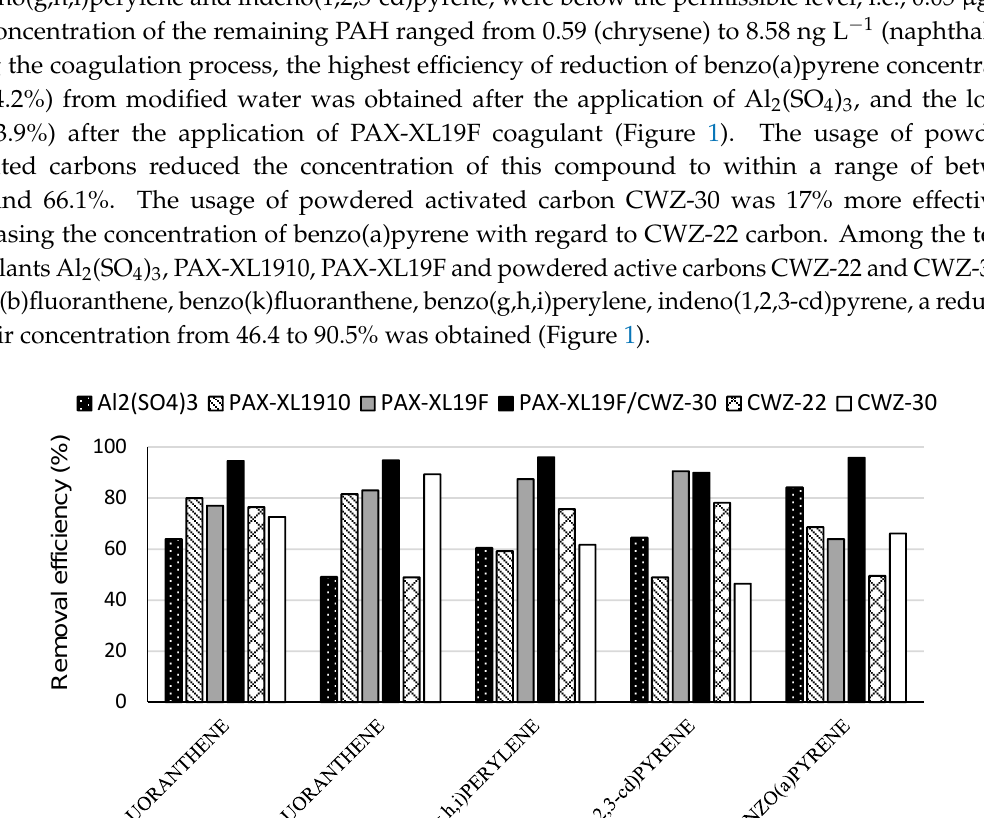
Figure 2. Removal efficiency of sum PAH standardized in the Council Directive 98/83/EC on the quality of water intended for human consumption. Among the tested coagulants Al 2 (SO 4 ) 3 , PAX ‐ XL1910, PAX ‐ XL19F and powdered active carbons CWZ ‐ 22 and CWZ ‐ 30, the lowest PAH removal from water efficiency was obtained for 2 ‐ and 3 ‐ ring compounds (Figure 3). In case of 2 ‐ ring naphthalene, the removal efficiency ranged from 34.9 (Al 2 (SO 4 ) 3 ) to 57.8% (PAX ‐ XL19F). For 3 ‐ ring PAH, a reduction in concentration by 54.8 to 71.1% was obtained. In this group of compounds, after application of Al 2 (SO 4 ) 3 for coagulation, a reduction in